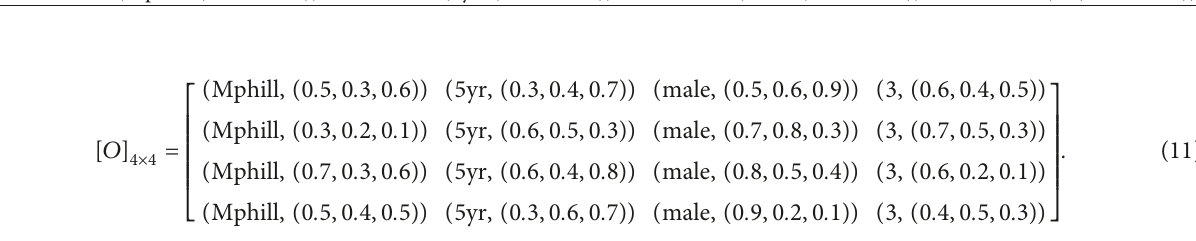
Table 3: Decision makers will assign neutrosophic numbers to each candidate T